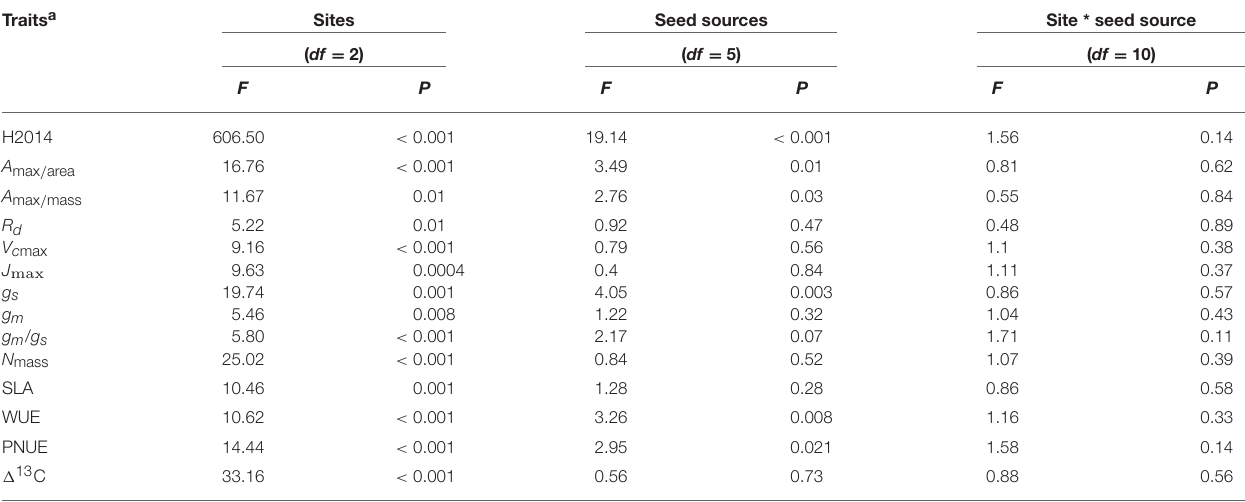
TABLE 2 | Analysis of variance for growth and functional traits for sources of variation (sites, seed sources and the site * seed source interaction), degrees of freedom ( df ), F -values, and associated probabilities ( P ). Traits a Sites Seed sources Site * seed source